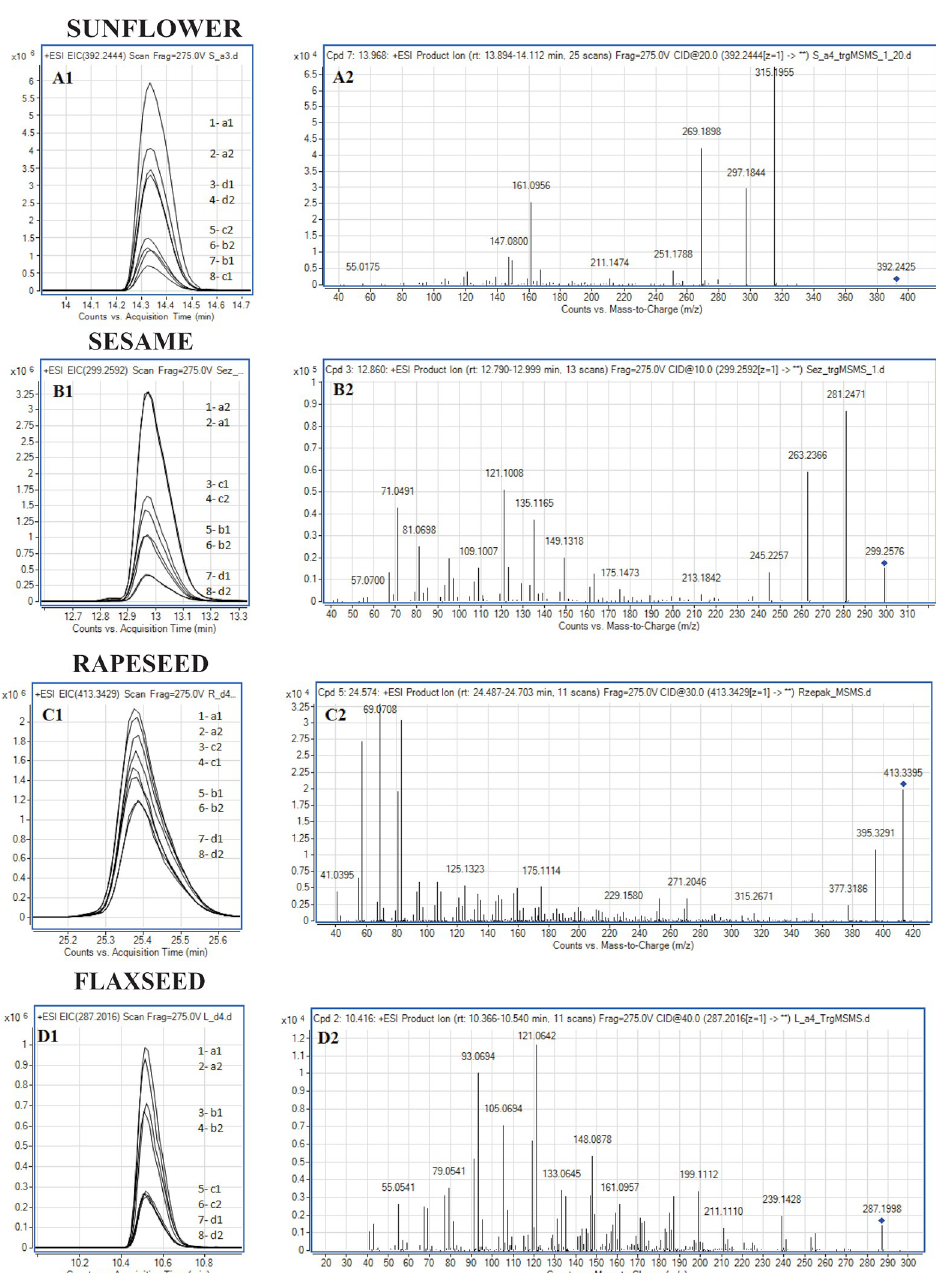
Fig 3. Extracted ion chromatograms (EIC) and MS/MS mass spectra of metabolomic markers for sunflower seed oil, sesame oil, rapeseed oil and flaxseed oil. EIC for eight different oil samples (manufacturers marked by a-d letter, batch by 1–2 number) are